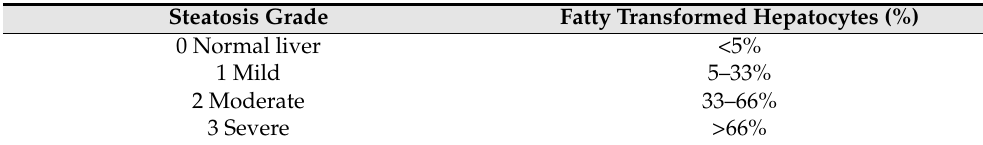
Table 1. The pathohistological grading of HS depending on the percentage of fatty transformed hepatocytes